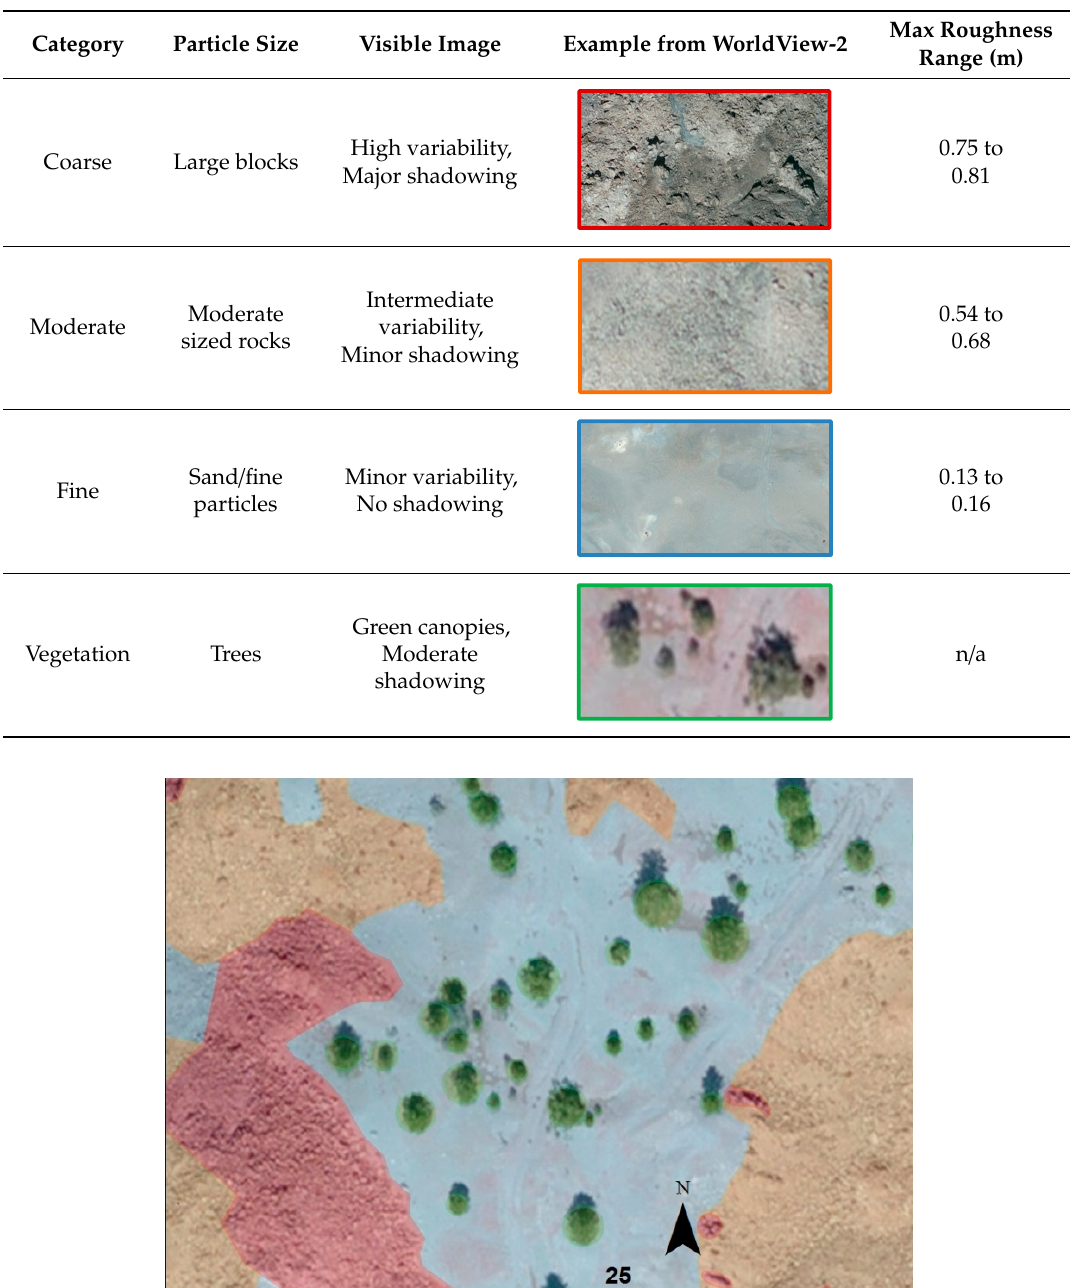
Table 2. Description of the three particle size category types (plus vegetation) used to classify the image based on the surface characteristics. Roughness was calculated from photogrammetry. Colors correlate to the categories shown in Figure 3.